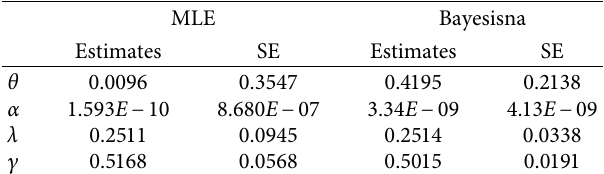
Table 7 discussed MLE and Bayesian estimation methods comparing by SE, we note Bayesian estimation has smaller SE than MLE.